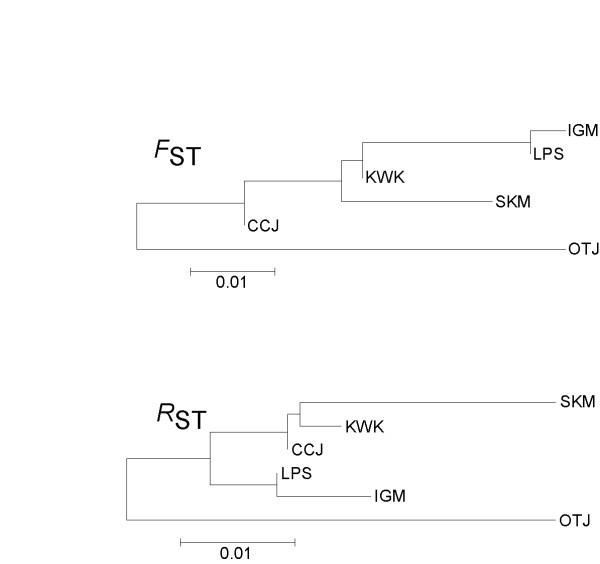
Neighbour-joining trees based on pair-wise FST and RST among operational populations of M. boninensis.